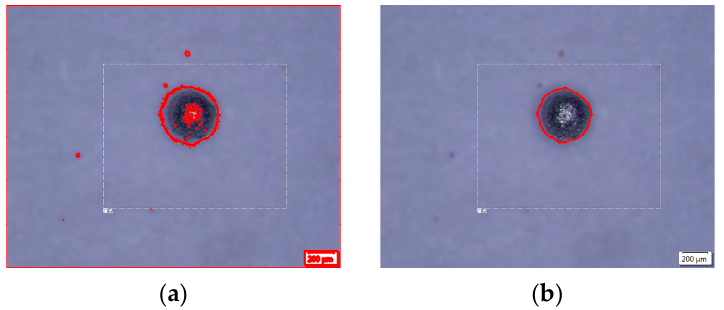
Figure 9. Oil-particle contour-extraction image after using the Canny edge detection algorithm: ( a ) contours without morphological processing; ( b ) morphologically processed contours.